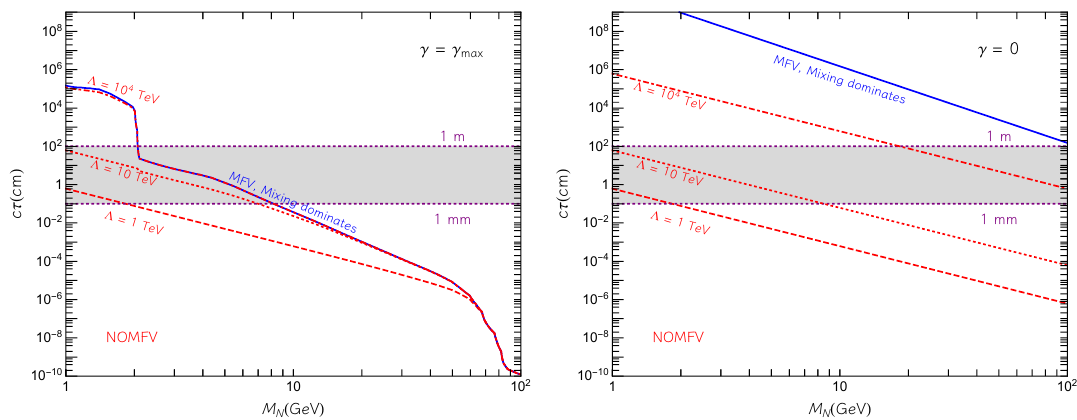
Figure 2 . Proper decay length c(cid:28) of the sterile neutrinos as a function of the mass scale M N for di(cid:11)erent choices of parameters: (cid:13) = (cid:13) max and (cid:11) = 0 (left) and (cid:13) = 0 and (cid:11) = (cid:25)= 4 (right). The red lines show the results without assuming MFV for three di(cid:11)erent values of the new physics scale: (cid:3) = 1 TeV (dashed line), (cid:3) = 10 TeV (dotted line) and (cid:3) = 10 4 TeV (dot-dashed line). The blue lines are instead drawn assuming MFV, with the decay rate driven by the mixing. In the gray region the decay will produce a detectable displaced vertex at the LHC